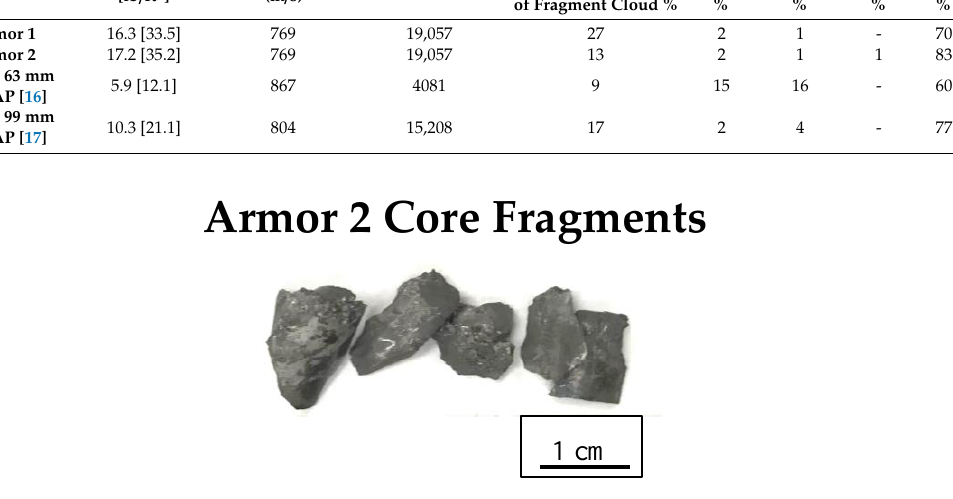
Figure 8. Fragments of the fractured steel core retrieved from Armor 2 (PP) following testing.